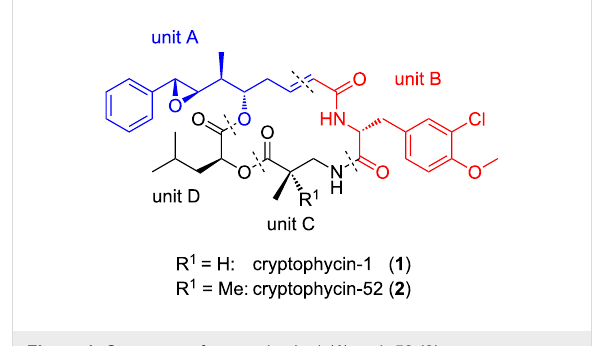
Figure 1: Structures of cryptophycin-1 ( 1 ) and -52 ( 2